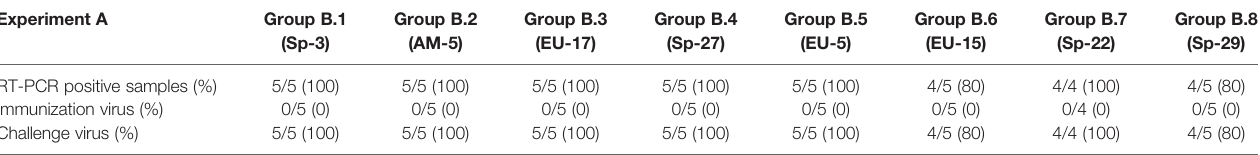
TABLE 5.2 | Results of PRRSV RT-PCR and PRRSV isolate identi fi cation by sequencing from tonsils collected at necropsy from pigs in Experiment B. Experiment